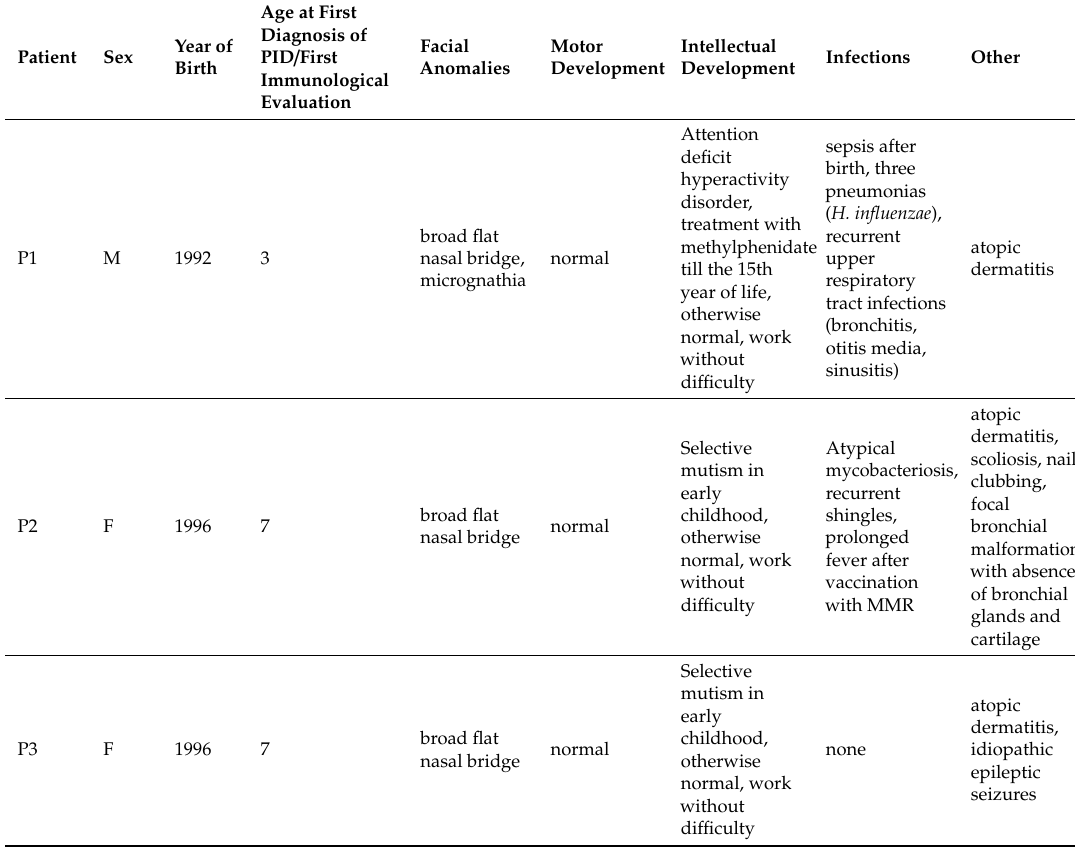
Table 1. Characteristics of three patients with